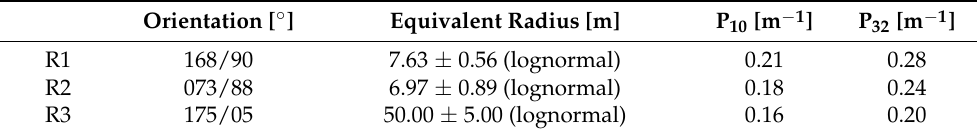
Table 1. Geometrical properties of the fracture sets from the Remlingen quarry (R1–3) [50]. P 10 and P 32 represent the number of fractures per unit length and the area of fractures per unit volume, respectively.